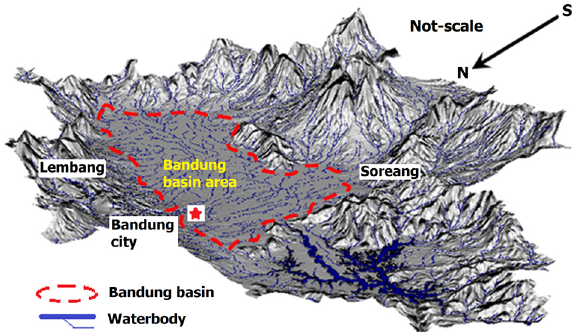
Fig. 2. 3D view of the SRTM30 DEM for the Bandung Basin area (Cekungan